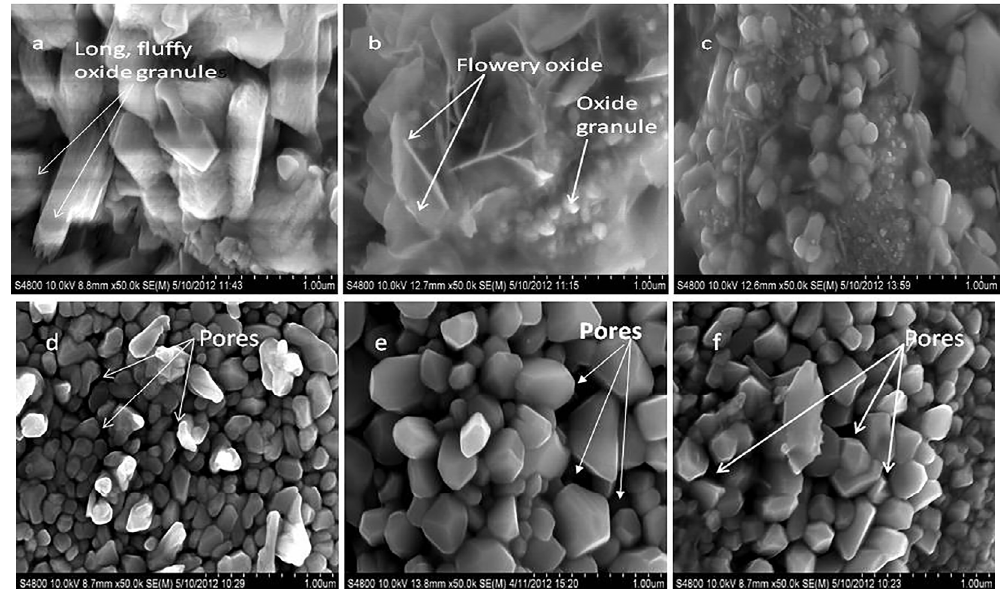
Figure 2. Scanning electron microscope (SEM) images of thermally oxidized C84400 in different oxidizing atmospheres: ( a , b , c ) 1, 2, 3 h in N -5 wt.% O gas mixtures, respectively, at 650 in N 2 2